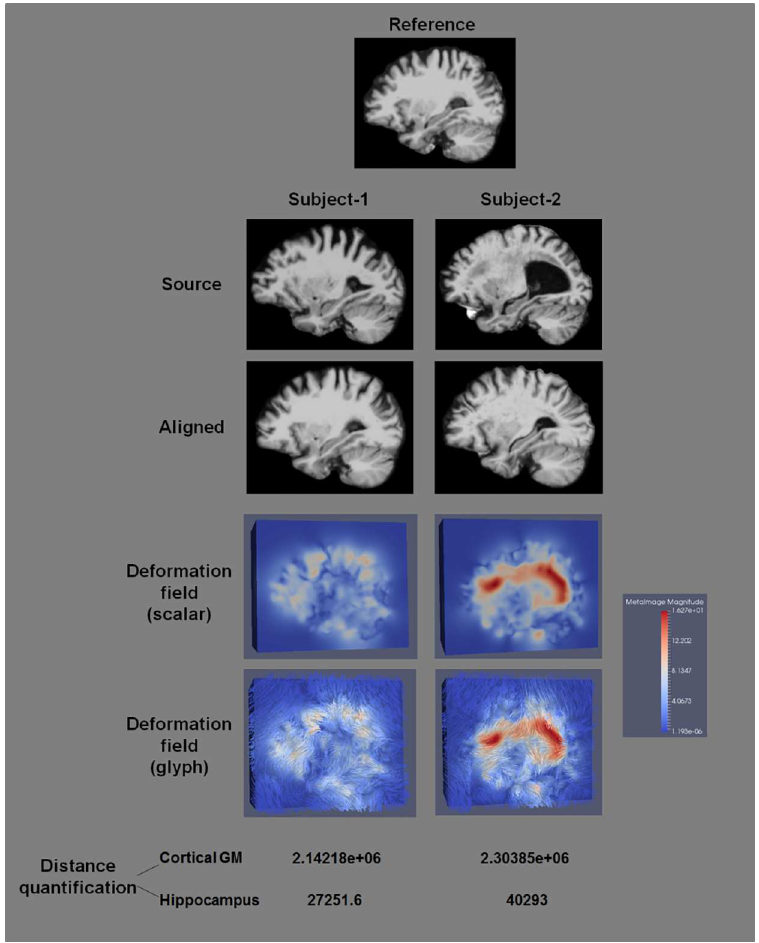
Fig 2. Comparison between different subjects in their deformable registration, deformation fields, and quantified distances. The symmetric log-domaindiffeomorphic demons registration well alignedthe reference and source images, providing informativedeformationfields that accuratelyreflect morphological difference betweensubjects.